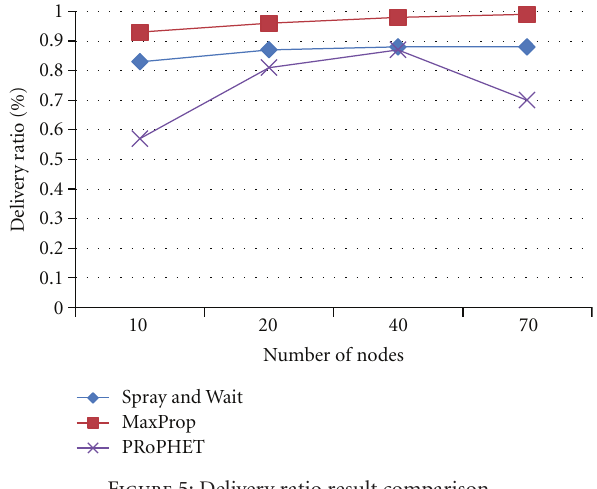
Figure 5: Delivery ratio result comparison.